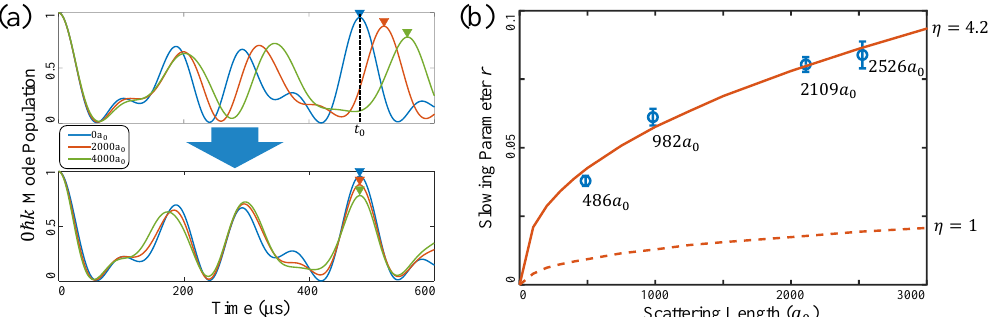
Figure 6: (a) 1D GPE calculation illustrating the slowing of the time evolution of the zeroth order diffraction peak with interaction strength. The curves can be aligned by re-scaling in time to match the first condensate recurrence points to the null inter- action case ( t → t / ( 1 + r ) ). (b) The delay parameter r inferred from experimental measurements (circles) in Figure 4 versus the dimer-dimer scattering length a . dd Error bars generate with 10 repeated measurements. Solid line and dash line are = 50 E produced by GPE simulation with U for η = 4.2 and η = 1, where η is r 0 the phenomenological factor we included to account for additional contribution to interaction, g = η g (section 1 D